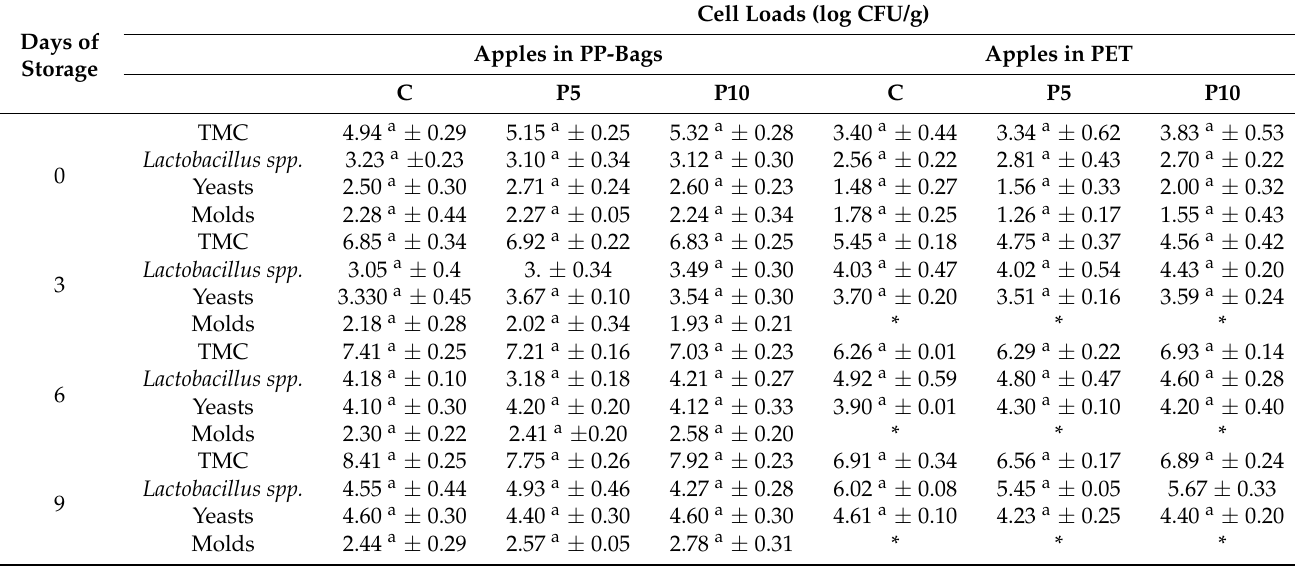
For each sampling time and microbial group, different letters indicate significant differences ( p < 0.05) among untreated samples (C) and plasma-treated samples (P5 and P10); * = below the limit of determination (<2 log CFU/g).